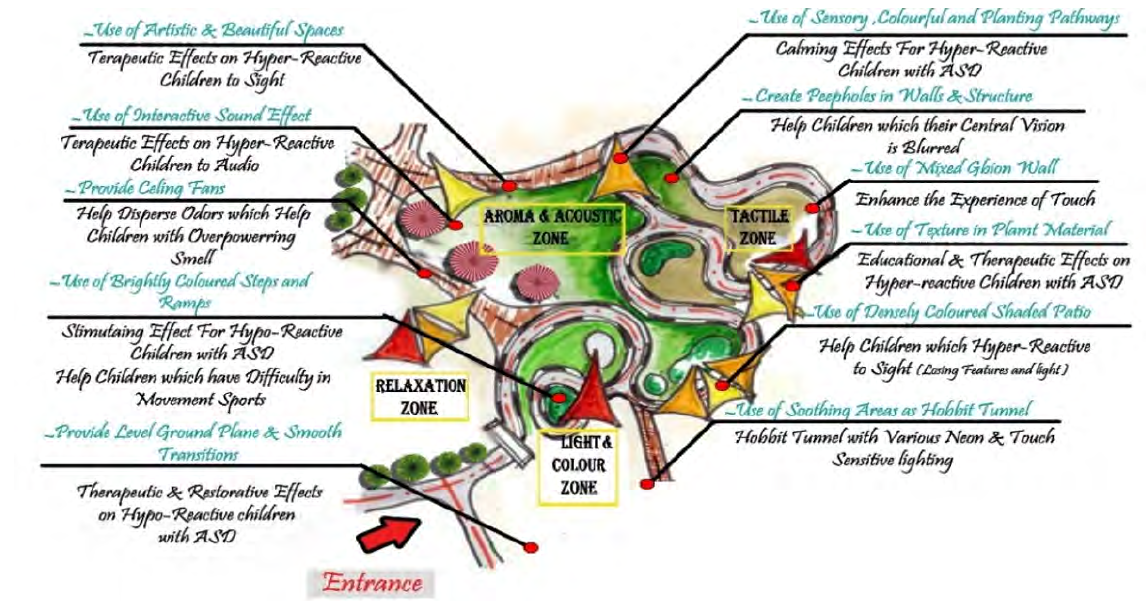
Figure 13. Shows the design consideration for the sensoryplay